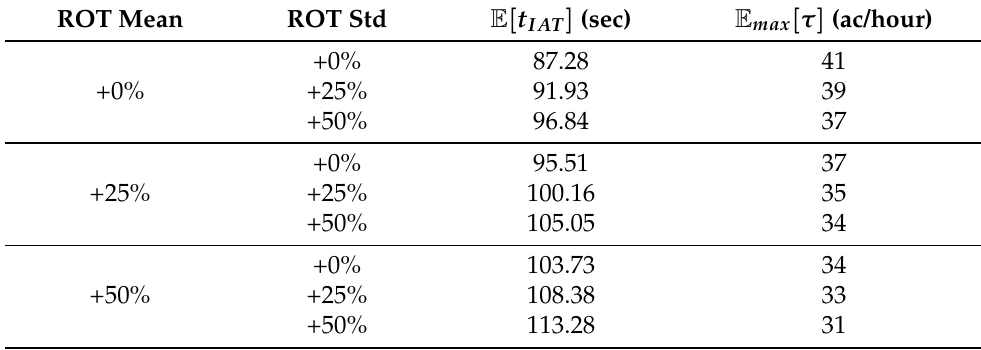
Figure 9. Nine cases of t ROT distributions ( blue ) and t IAT distributions of arrival aircraft pairs with a separation minimum of 3 NM ( red ) that maximize the runway capacity while satisfying the ROT constraints in each case. Table 6. Estimating the maximum runway capacity according to the ROT